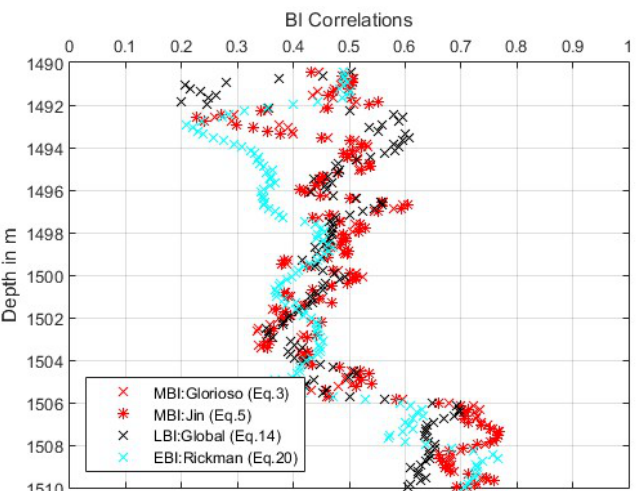
Figure 8. BI correlations from the Chattanooga Shale applied over depth. Black colors show LBI correlations, red colors show MBI correlations, and blue colors indicate EBI correlations. The sharp change at 1506 m depth is due to a change in lithology from a silt dominated lithology with lower BI values to a dolomite dominated lithology with significantly higher values for BI.